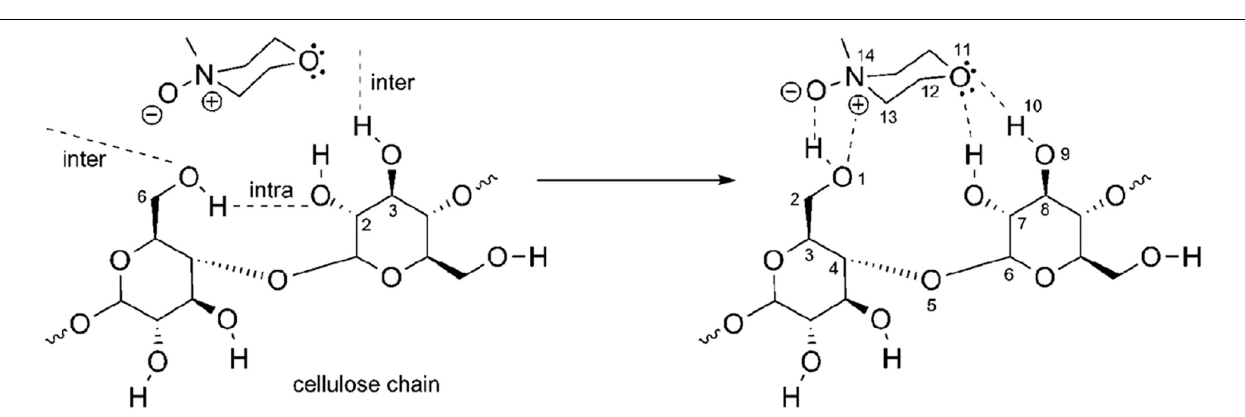
FIGURE 6 | N -methylmorpholine- N -oxide–cellulose dissolution mechanism: Reprinted with permission from Pinkert et al. (2010). Copyright (2010) American Chemical